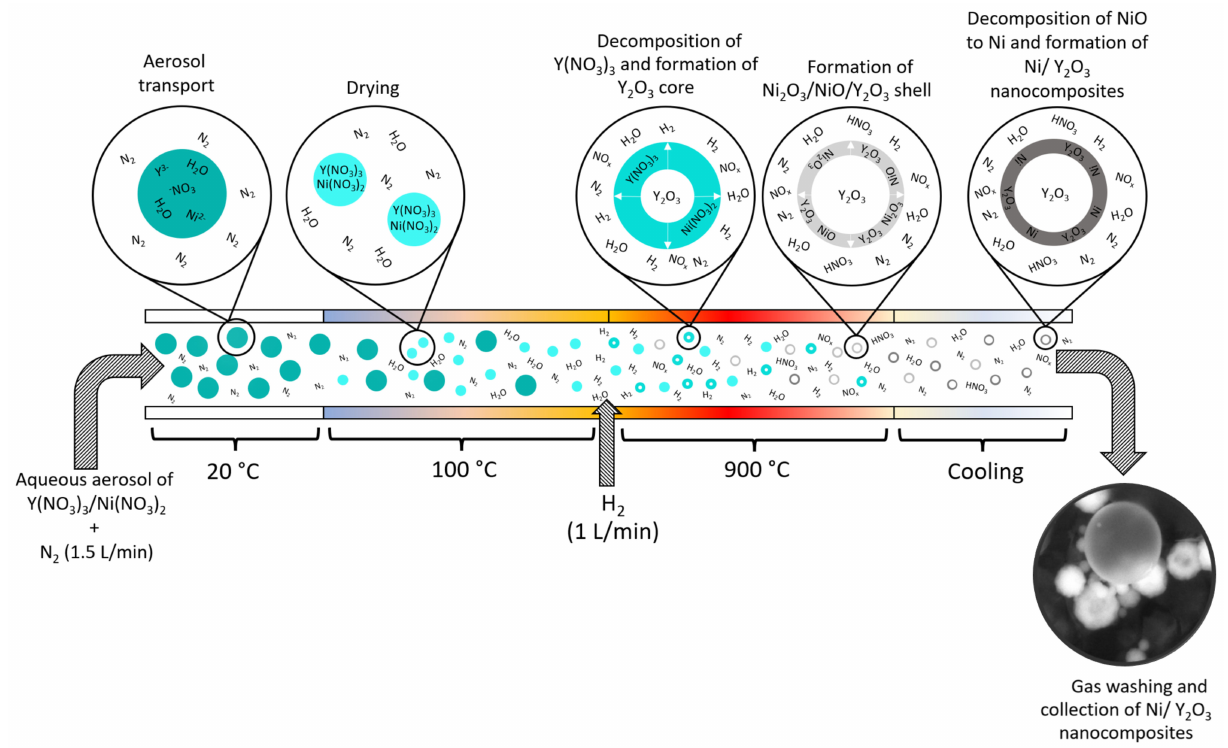
Figure 14. Schematic presentation of Ni/Y 2 O 3 nanocomposite particles through